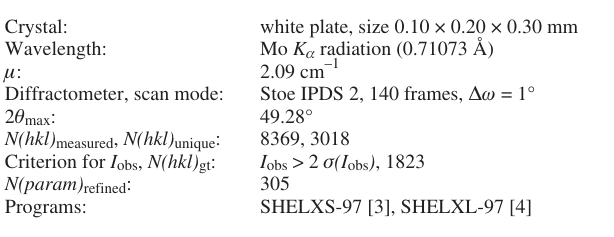
Table 1. Data collection and handling.